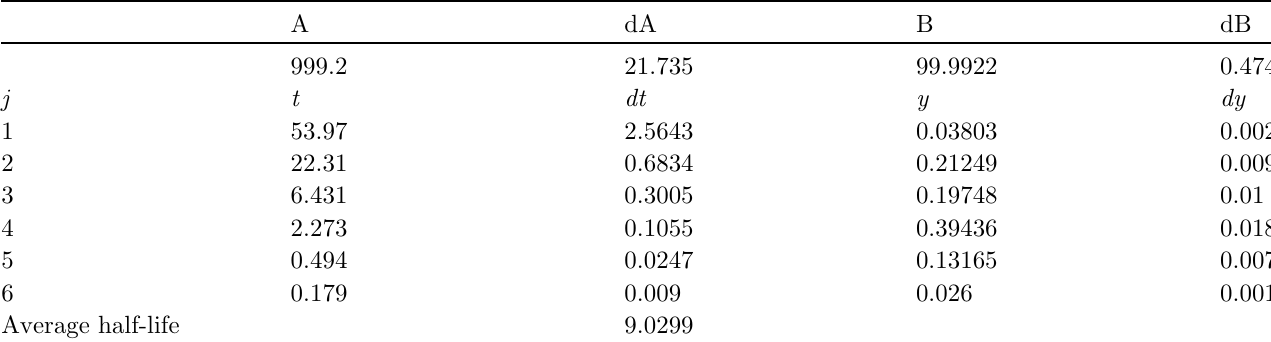
, T ) obtained in the LSF processing of the model decay curve calculated i i